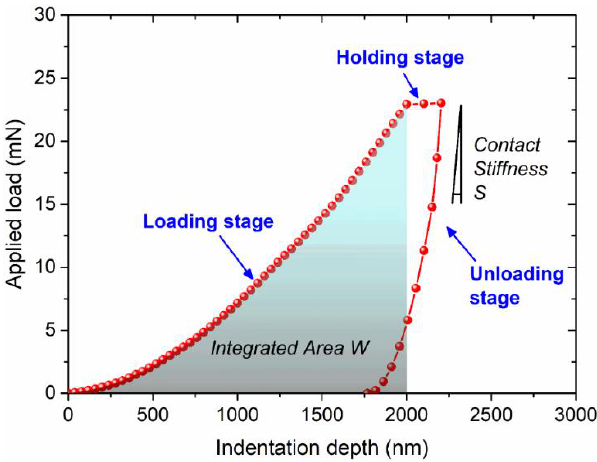
Figure 2. Typical nanoindentation response in the form of applied load–indentation depth.